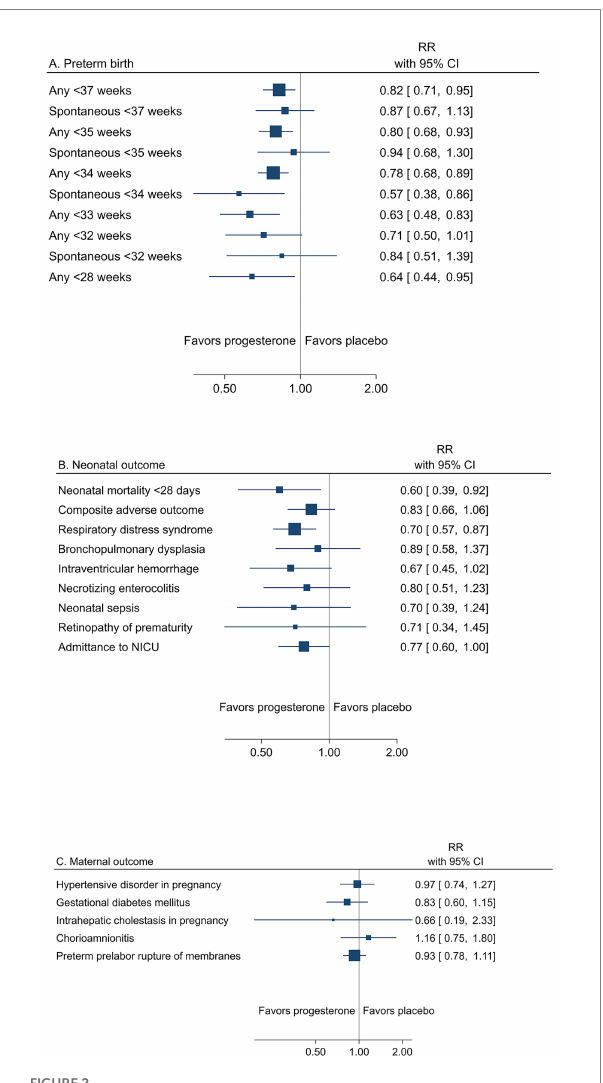
FIGURE 2 Summary graph of pooled estimates from meta-analyses comparing progesterone and placebo in women with a singleton pregnancy and any type of risk factor for preterm birth, from trials with low risk of bias regarding (A) preterm birth, (B) neonatal, and (C) maternal